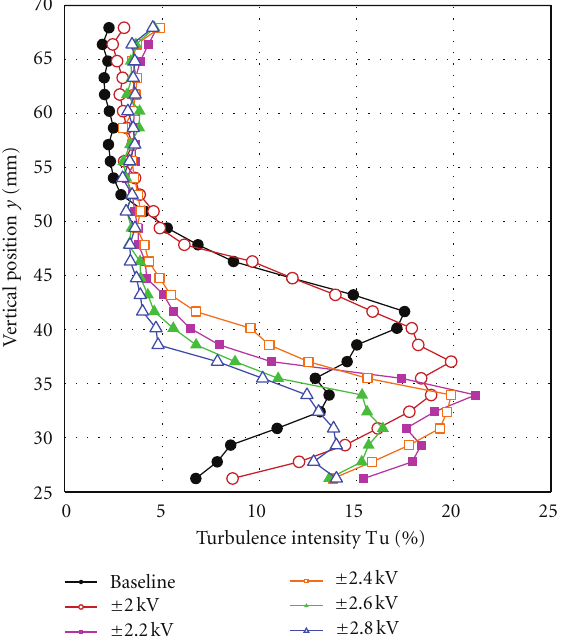
Figure 14: Turbulence intensity distributions near trailing edge ( x = 99.1 mm).